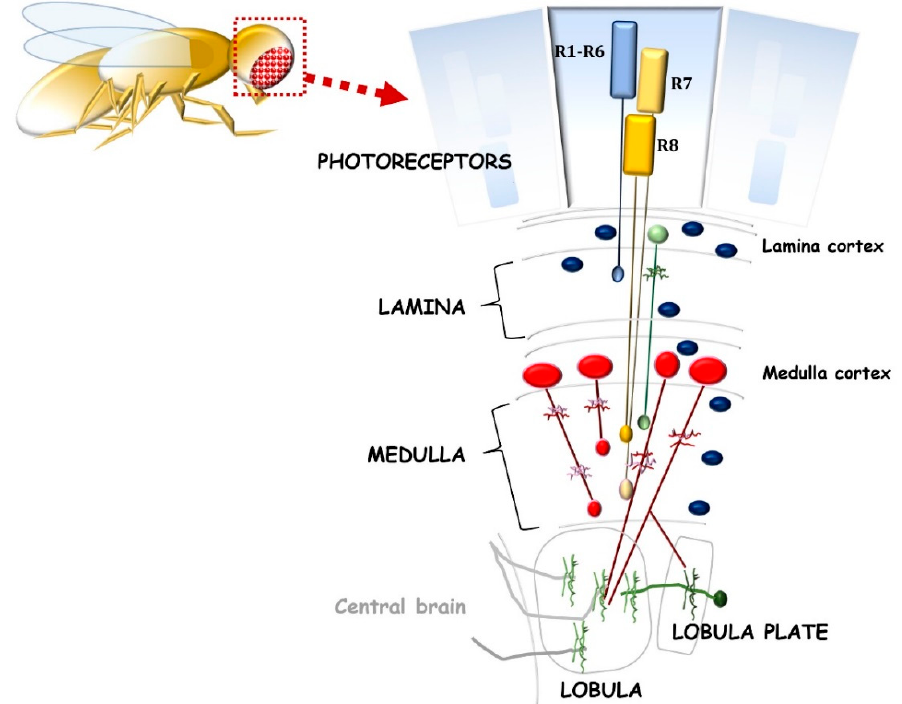
Figure 2. Schematic representation of the drosophila visual system, including the retina and optic neuropils: lamina, medulla, lobula, and lobula plate. Photoreceptors R1–R6 (blue bars) innervate the lamina, and R7–R8 (yellow bars) innervate the medulla. Green, red and blue cells represent lamina neuron, various medullary neurons, and glial cell types, respectively.